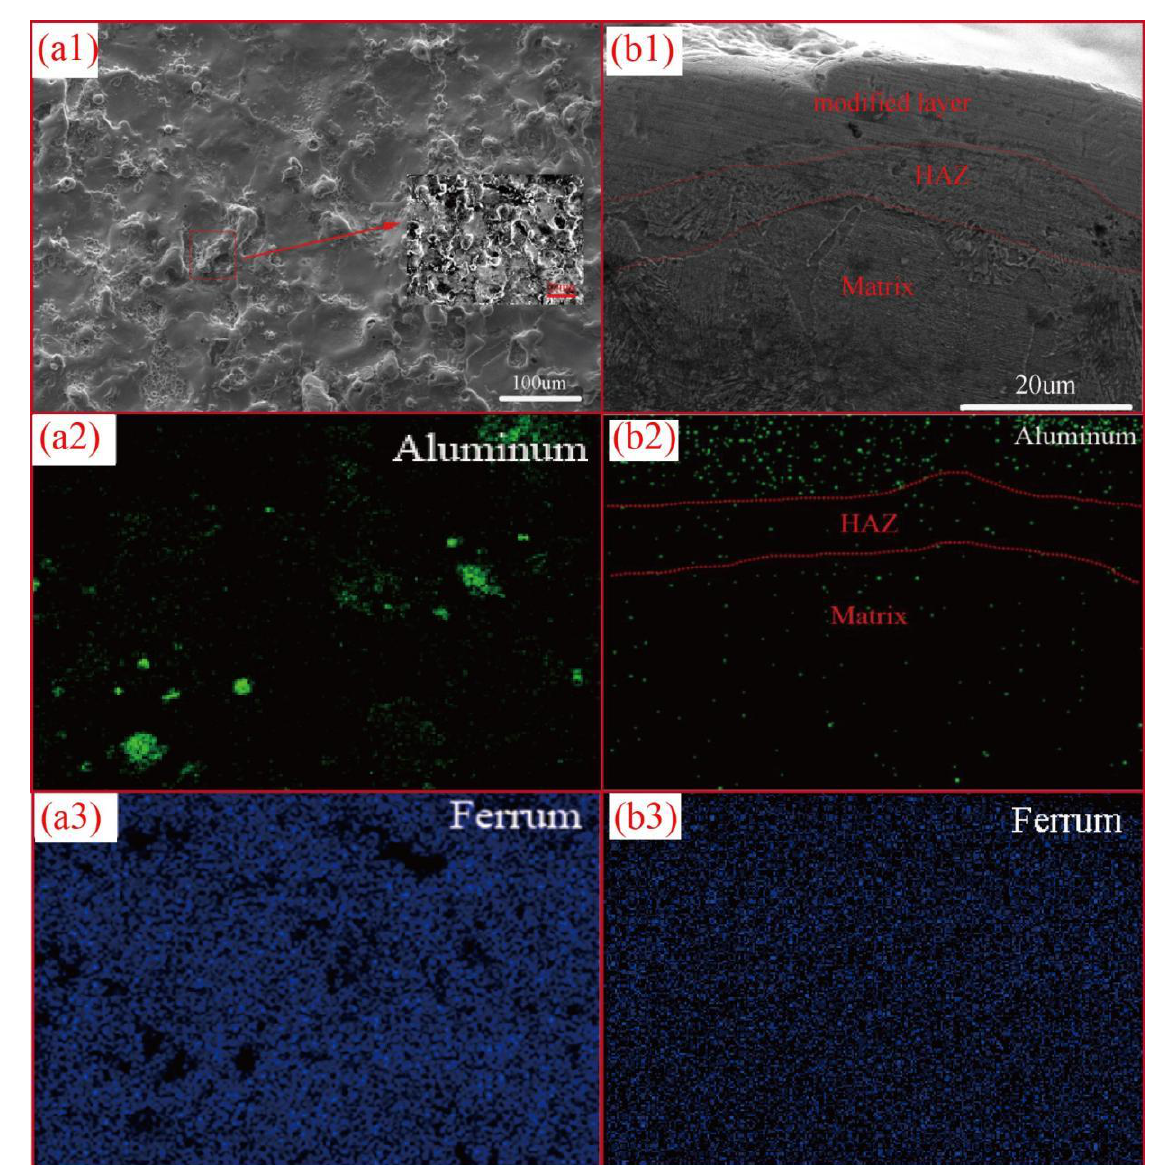
Figure 5. SEM images and element mapping images of surface morphology ( a1 – a3 ) and cross-sectional morphology ( b1 – b3 ) of 12A PMEDA machined samples.